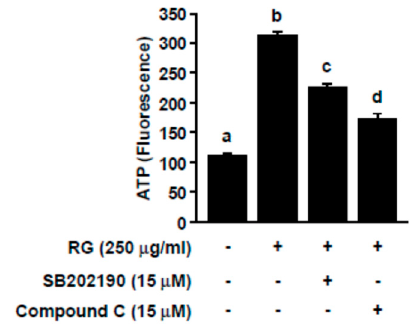
Figure 5. Effects of p38 and AMPK inhibition on RG-induced ATP levels in C2C12 myotubes. After differentiation, cells were treated with SB202190 (p38 inhibitor) or Compound C (AMPK inhibitor) for 30 min, prior to treatment with RG. Then, ATP levels were evaluated. Data are expressed as mean ± S.D. Bars with different letters mean significant differences from each other ( * p < 0.05).